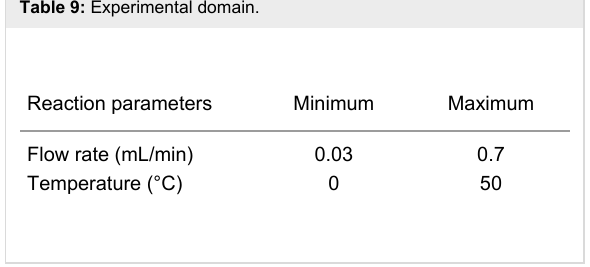
Table 9: Experimental domain.